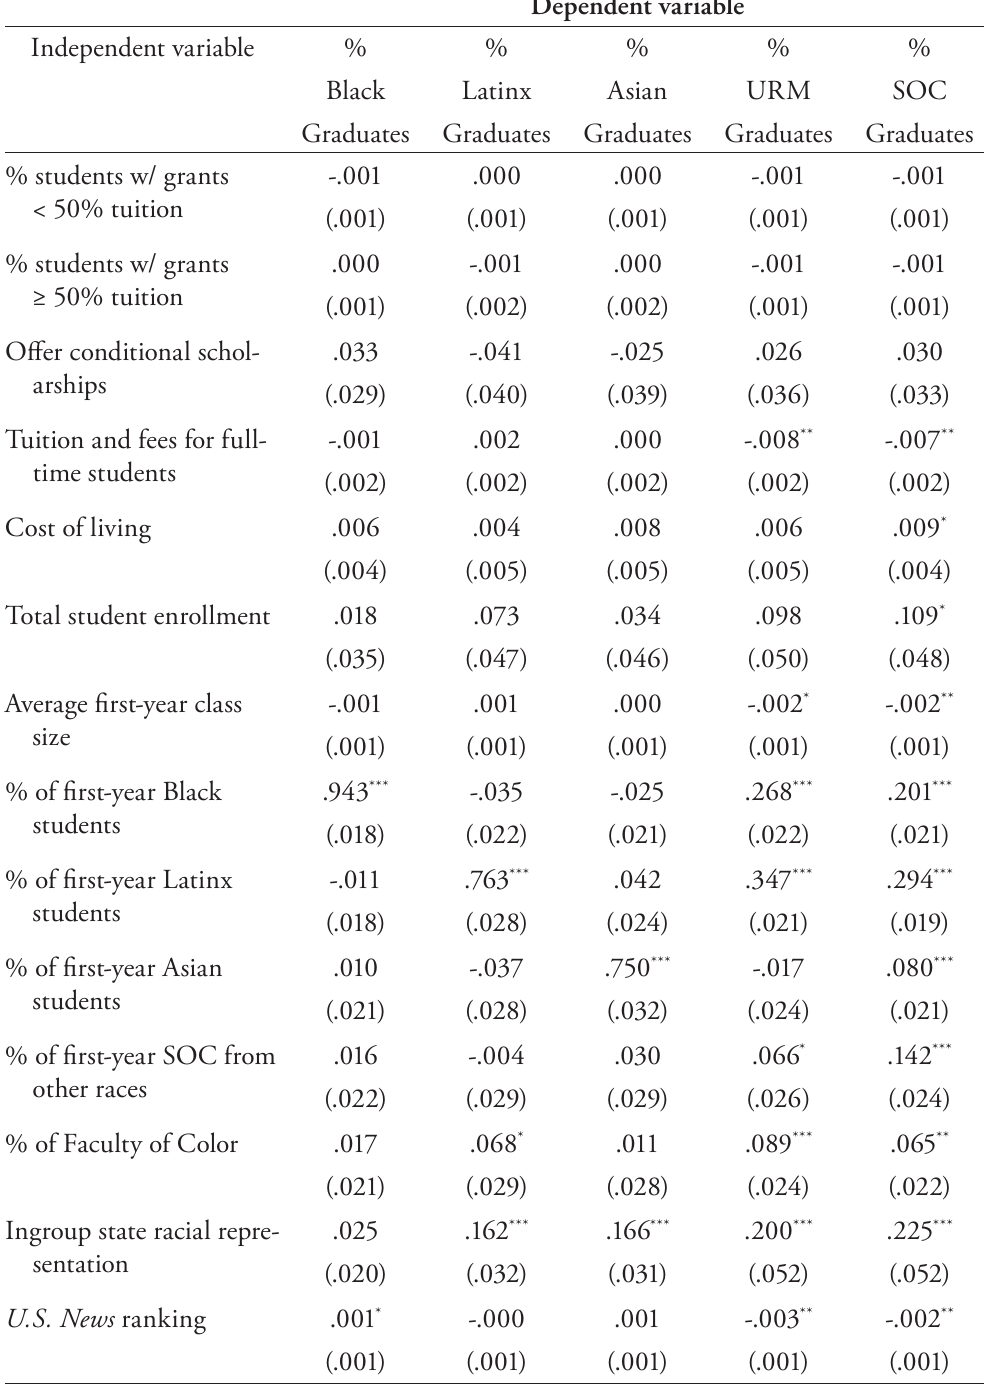
Table 6. Unstandardized Coefficients for Random Effects Analyses